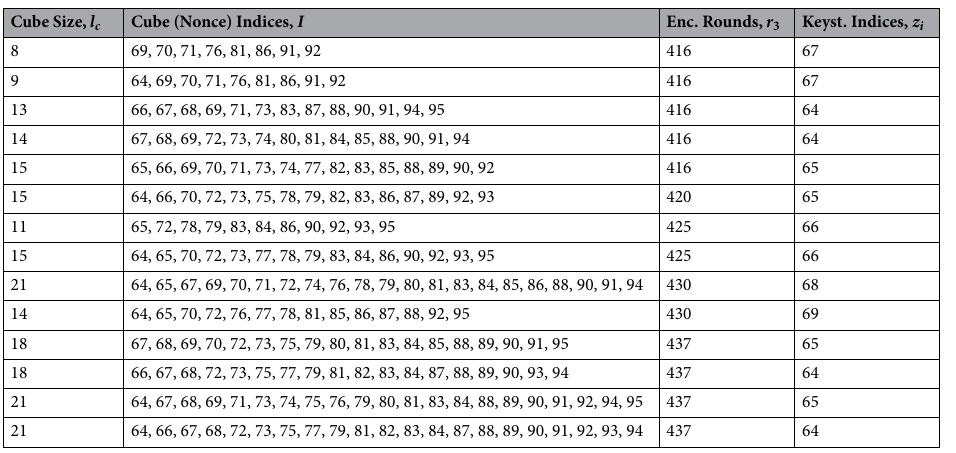
Table 7. Examples of cube testers for DA2 with reduced cube space ( V { 64, ··· ,95 } )